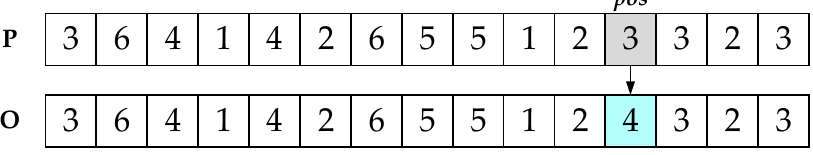
Figure 11. An example of mutation for machine layer.